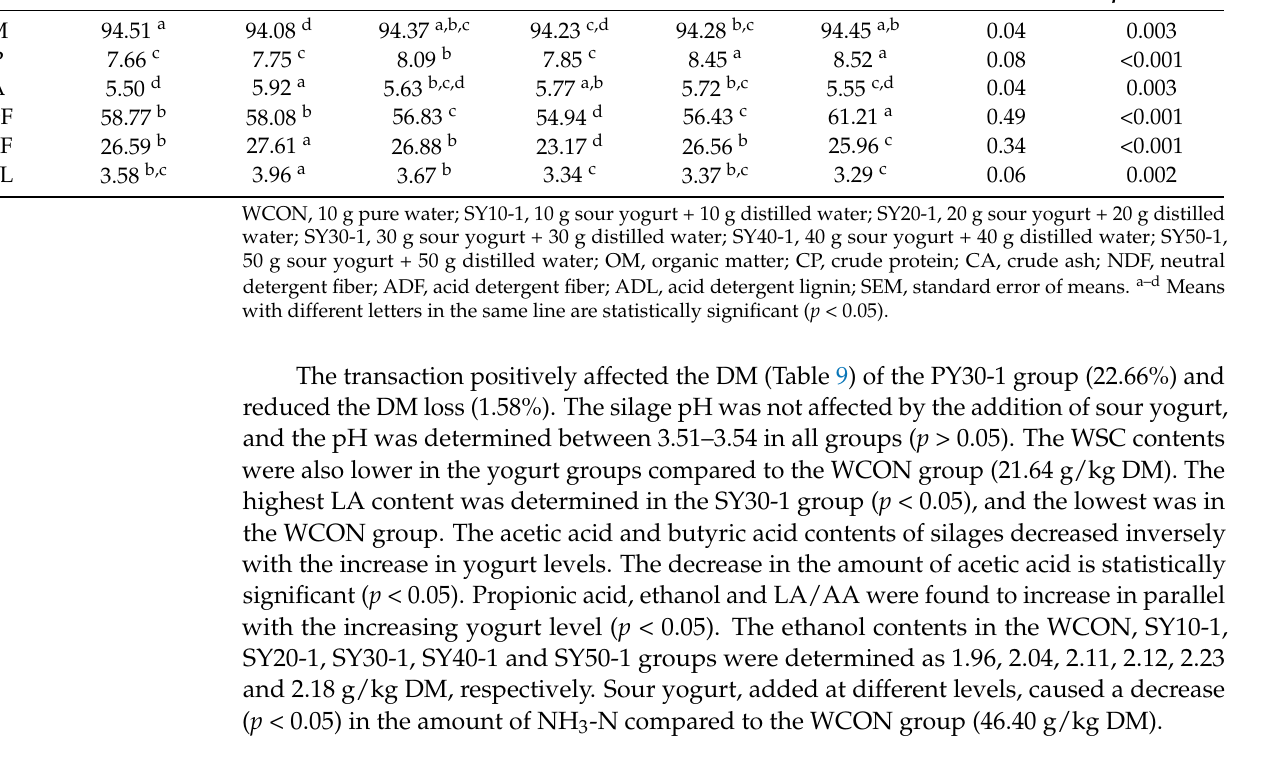
Table 9. Fermentation quality of corn